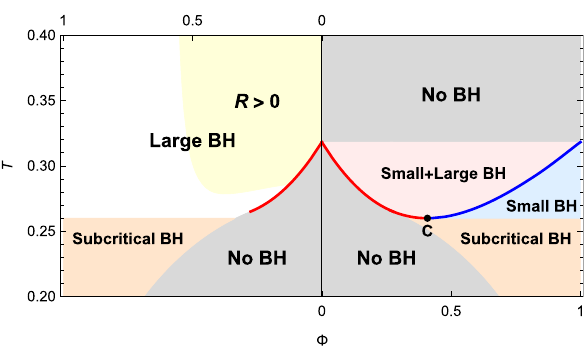
Fig. 5 Phase structure of a RN-AdS black hole in the (cid:2) - T diagram. Thecriticalpoint(blackdot)separatesthesaturatedSmallBHandLarge BH, which are represented by the blue and red lines, respectively. Note that there are two black hole solutions for a fixed value of (cid:2) . The left/right frame shows the large/small Q black hole solution. In the yellow region, R > 0. The pink region is the coexistence region of Small BH and Large